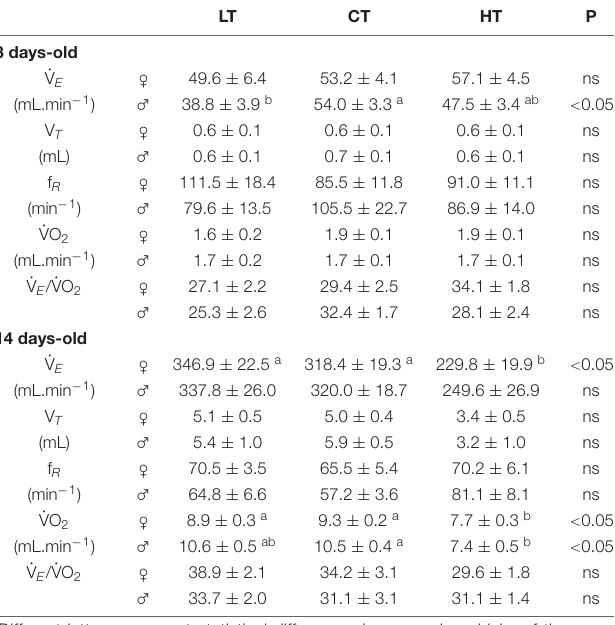
TABLE 1 | Values of body temperature (Tb), heart mass (HM), lung mass (LM), and body mass (BM) of 3 and 14 days-old female and male chickens that were incubated at control (CT; 37.5 ◦ C) or at higher (HT; 39 ◦ C) or lower (LT; 36 ◦ C) temperatures during 6 h/day, from day 0 to 5 of incubation.